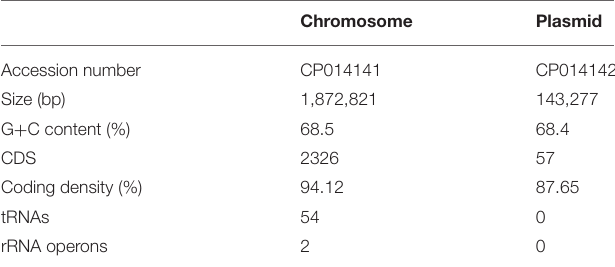
TABLE 2 | Genomic features of the chromosome and plasmid of T. parvatiensis strain